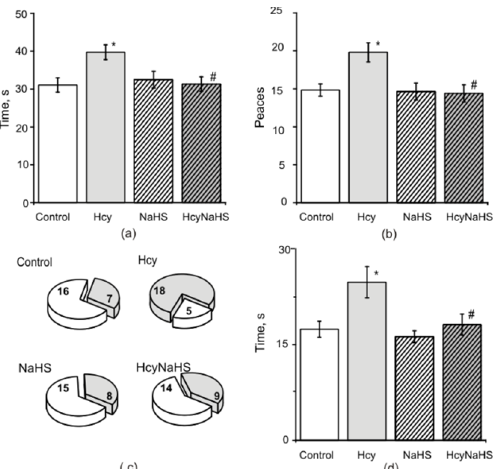
Figure 5. Effects of maternal hHcy and NaHS treatment on fine motor control. Average time to open and successfully consume five sunflower seeds ( a ) and the number of broken shell pieces ( b ) after consumption in the sunflower seed test. The ratio of atypical (grey sector) and typical (white sector) behavior patterns in the pasta handling test in control; Hcy, NaHS, and HcyNaHS groups (number of rats is indicated at the sectors) ( c ). The removal time in the adhesive test of rat from control (white columns), Hcy (grey columns), NaHS (dashed columns), HcyNaHS (grey dashed columns) groups ( d ). Data are expressed as mean ± SEM. * p < 0.05 compared to the control group, # p < 0.05 compared to the Hcy group.